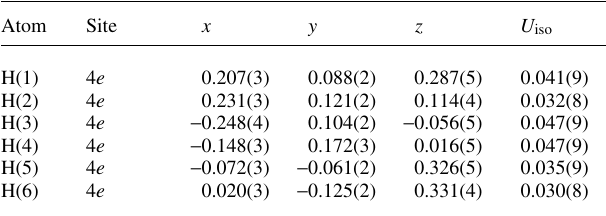
Table 10. Data collection and handling. Table 11. Atomic coordinates and displacement parameters (in Å 2 )